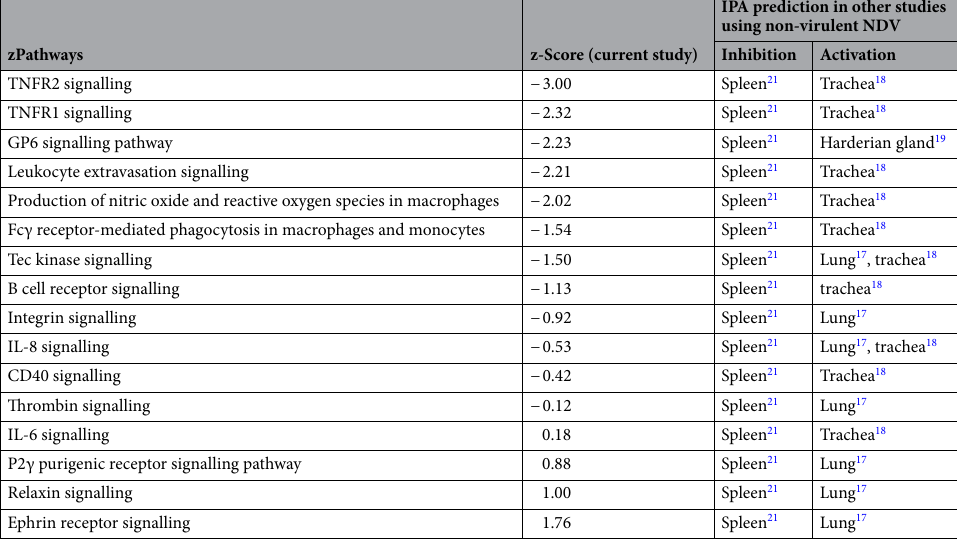
Table 4. Comparison of predicted pathways by IPA in current study with other studies that investigated the response to NDV infection. Minus z-score means inhibition and positive z-score means activation.